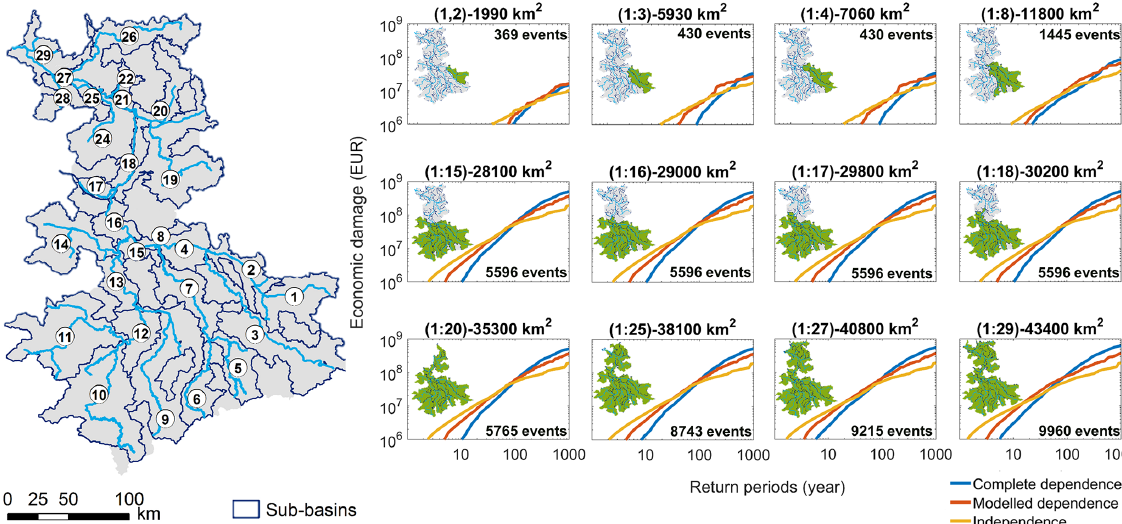
Figure 6. Sub-basins in the Elbe catchment (left) and risk curves of aggregations of sub-basins (right) under complete dependence, modelled dependence and independence. The aggregated sub-basins are ordered along increasing scale and are denoted by green within each risk curve and the colon (:) between start and end sub-basin numbers.